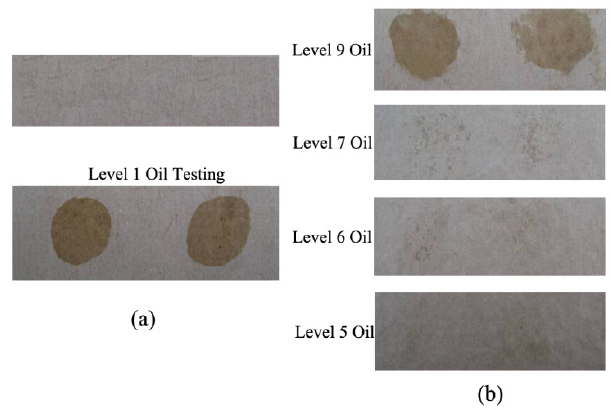
Figure 18. Oil resistance test of packaging paper with coating amount of 1.51 g/m 2 . ( a ) is the test of level 1 oil on packaging base paper; ( b ) is the test of different levels of oil on the paper with coating amount of 1.51 g/m 2 .